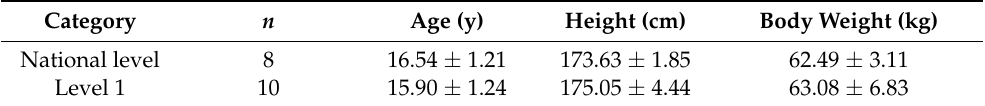
Table 2. Basic Profiles for Elite Male